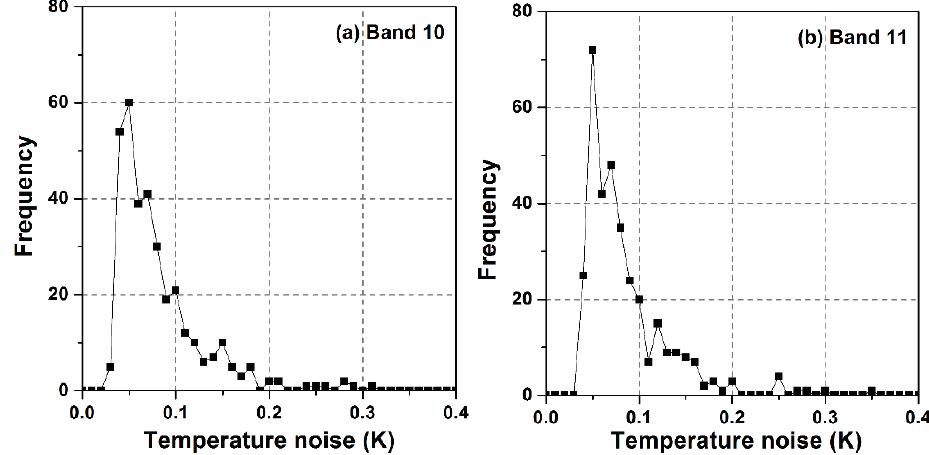
Figure 3. Histograms of temperature noise for the TIRS two bands based on the ground samples.